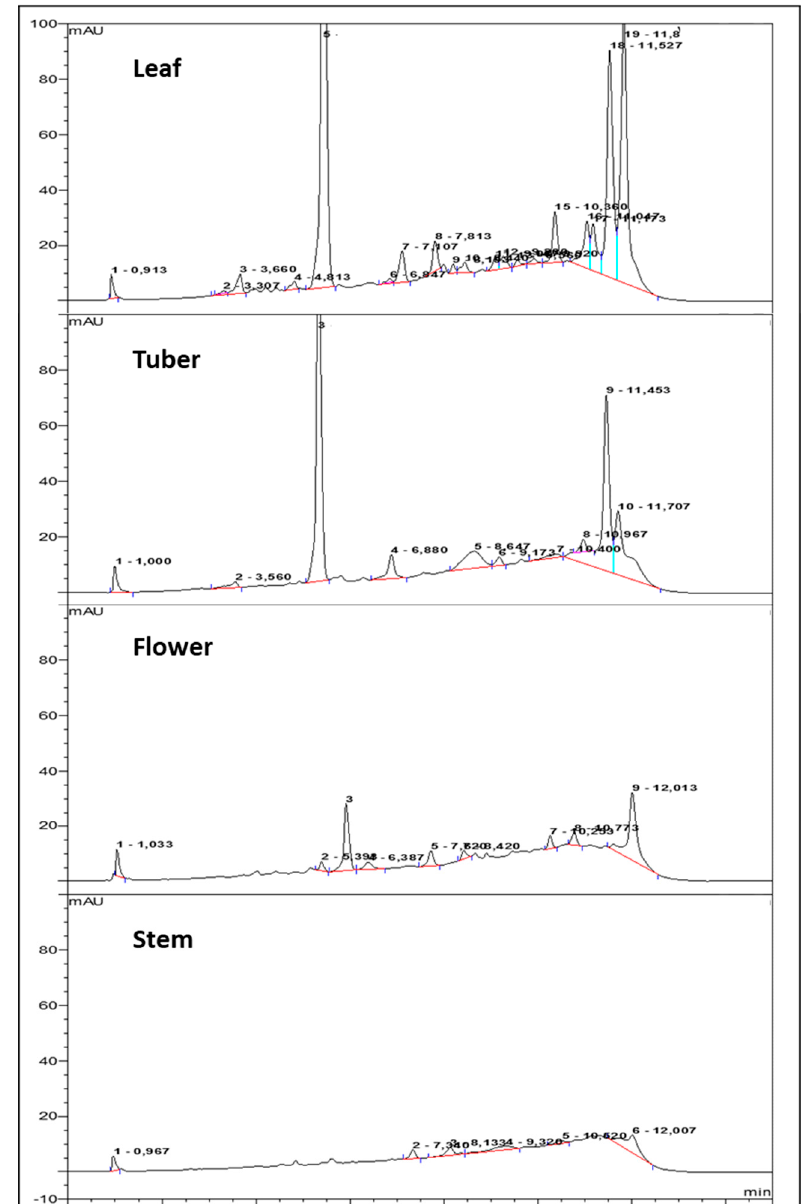
Figure 5. Response vs. acquisition time profiles from HPLC-UV analysis of microwave (MW) ethanol extracts of Jerusalem artichoke leaf, tuber, flower, and stem. The column used was a KINETEX 5 µm C18 100 mm × 4.6 mm (25 °C) and absorbance measured at 330 nm. The mobile phase (1.5 mL min − 1 ) was composed of water with 0.1% TFA (A) and Acetonitrile (B). The initial A/B ratio was 95/5, increasing to 80/20 over 10 min and held for 1 min during the analysis, before A/B again was returned to 95/5.